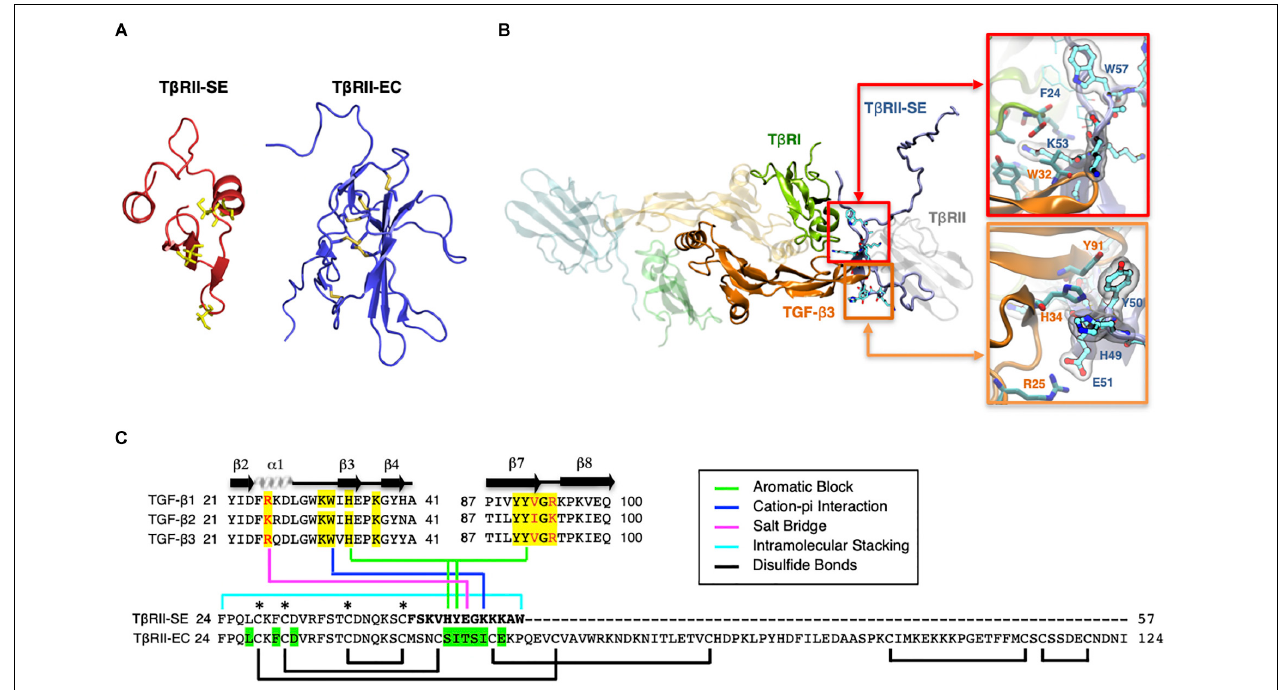
FIGURE 2 | 3D modeling reveals unique characteristics of T β RII-SE in comparison to the extracellular domain of membrane-bound T β RII. (A) T β RII-SE and T β RII-EC 3D models showing cysteine residues in yellow, and lack of disulfide bonds in T β RII-SE. (B) 3D model of mature T β RII-SE superimposed over the crystallographic structure of 2PJY (T β RII/T β RI/TGF- β 3) (left panel). The amino acid interactions between T β RII-SE (blue residues) and TGF- β 3 (orange residues) are shown magnified in the right upper and lower panels. (C) Amino acid sequence alignment of human TGF- β family members (top panel) showing residues interacting with T β RII-EC (yellow shading) and residues interacting with T β RII-SE (color lines linking the bottom panel). Green shading indicates residues in T β RII-EC interacting with TGF- β cognate ligands. Brackets and asterisks indicate cysteine residues forming and not forming disulfide bonds in T β RII-EC and T β RII-SE,